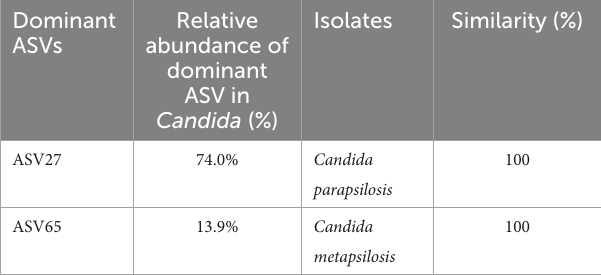
TABLE 1 Isolation of Candida strains a